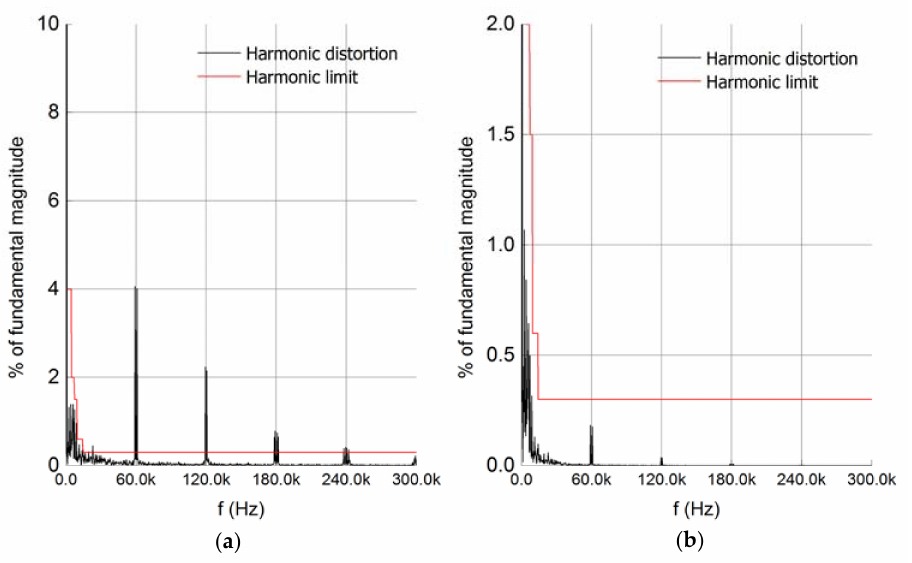
Figure 3. Current spectrum of the inverter and grid sides: ( a ) total harmonics distortion (THD) = 6.47%; ( b ) THD =